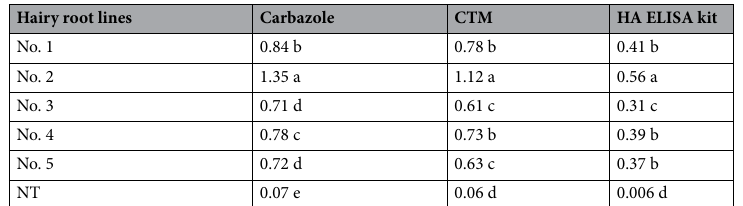
Table 2. Tukey pairwise comparisons of means (p < 0.05) were performed to compare the concentration of HA in transgenic hairy roots measured by Carbazole, CTM, and HA ELISA methods. Different letters followed by values in a column indicate significant differences at a 5% level of probability tested by Turkey’s test. Quantities are in g/kg (wet weight). NT non-transgenic.